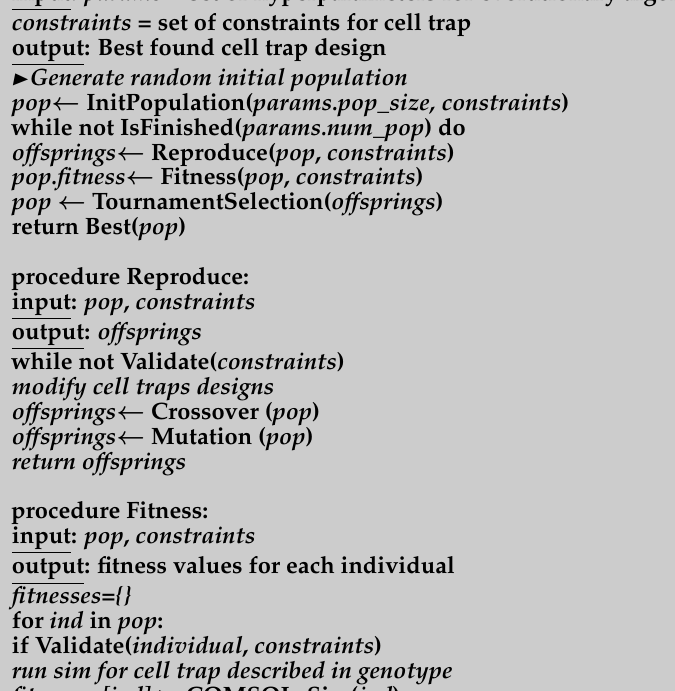
Algorithm 1: Evolutionary algorithm for cell trap design